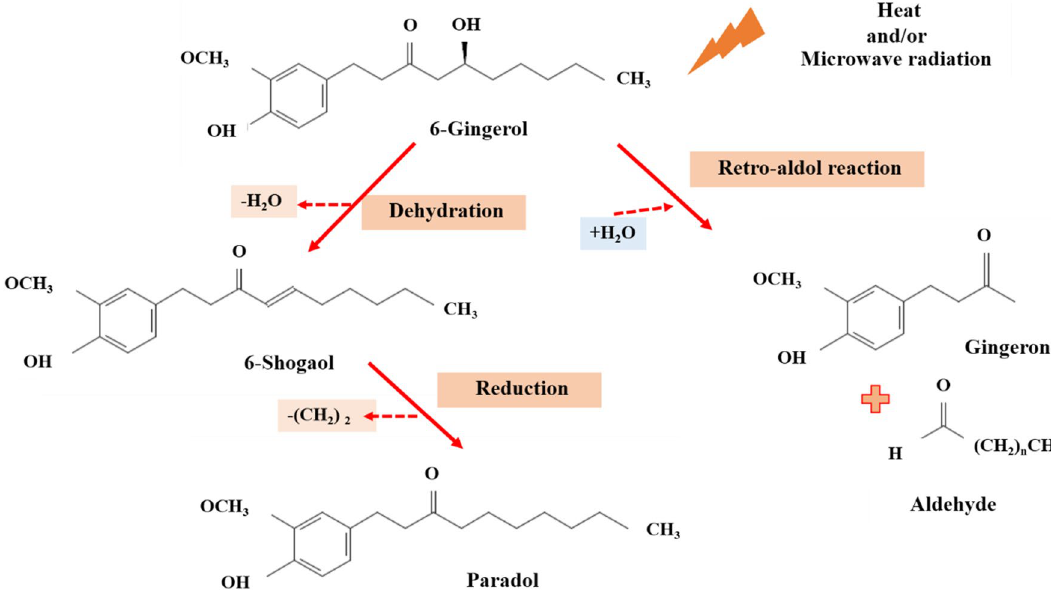
Figure 3. Conversion of 6-gingerol into 6-shogaol, paradol and zingerone through the heating and radiation power of the microwave